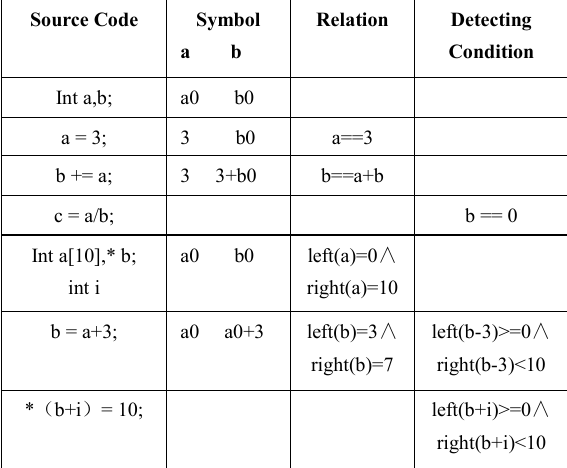
Table 1. Symbolizing variables and